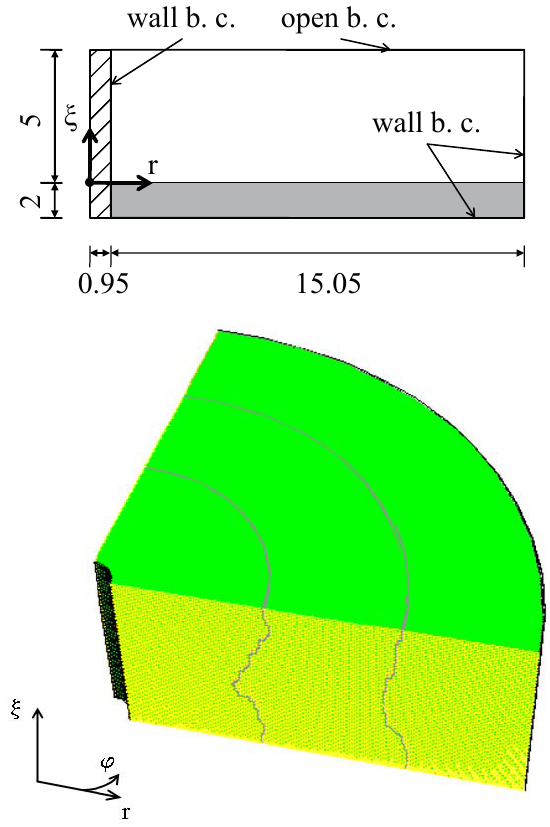
Figure 3. ( top ) Geometry and boundary conditions (b. c.) of the used numerical region (two-dimensional cross-section). The grey (shaded) region indicates the area of the magnetic fluid (wire). All measures are in millimetres. ( bottom ) Perspective view onto a quarter of the three-dimensional torus with an indication of its three subparts generated by FLUENT. The wall boundary conditions apply to the inner black curved area representing the rim of the wire, to the bottom of the torus (not visible in this perspective view), and to the outer black curved area (visible only as outer black